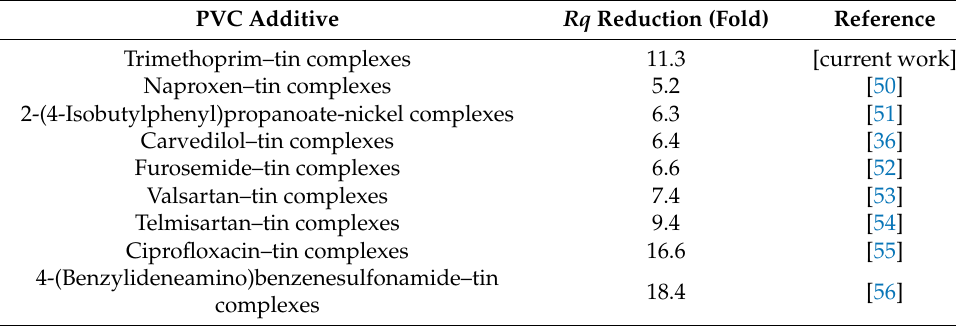
Table 4. Effect of various organotin complexes on the Rq for PVC films.